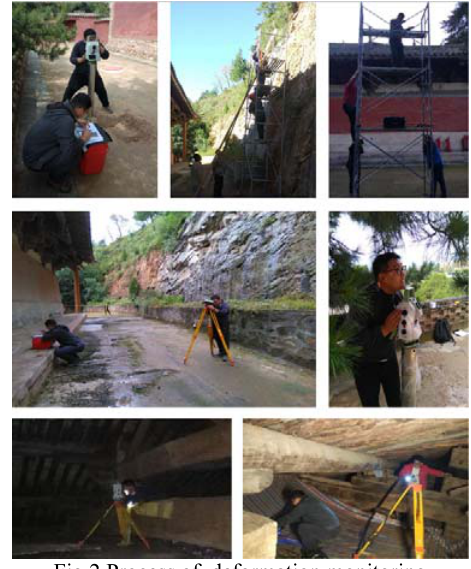
Fig.2 Process of deformation